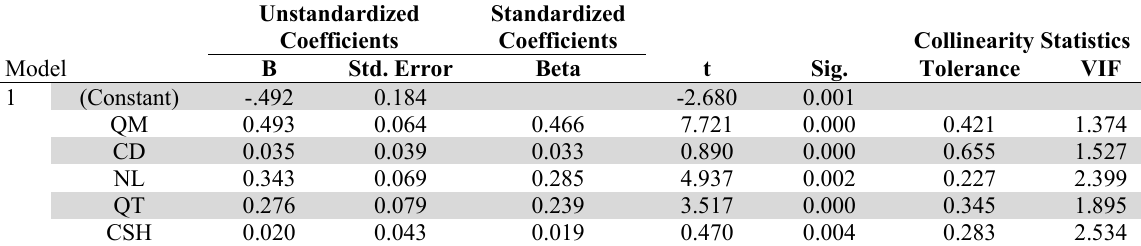
The results of Regression